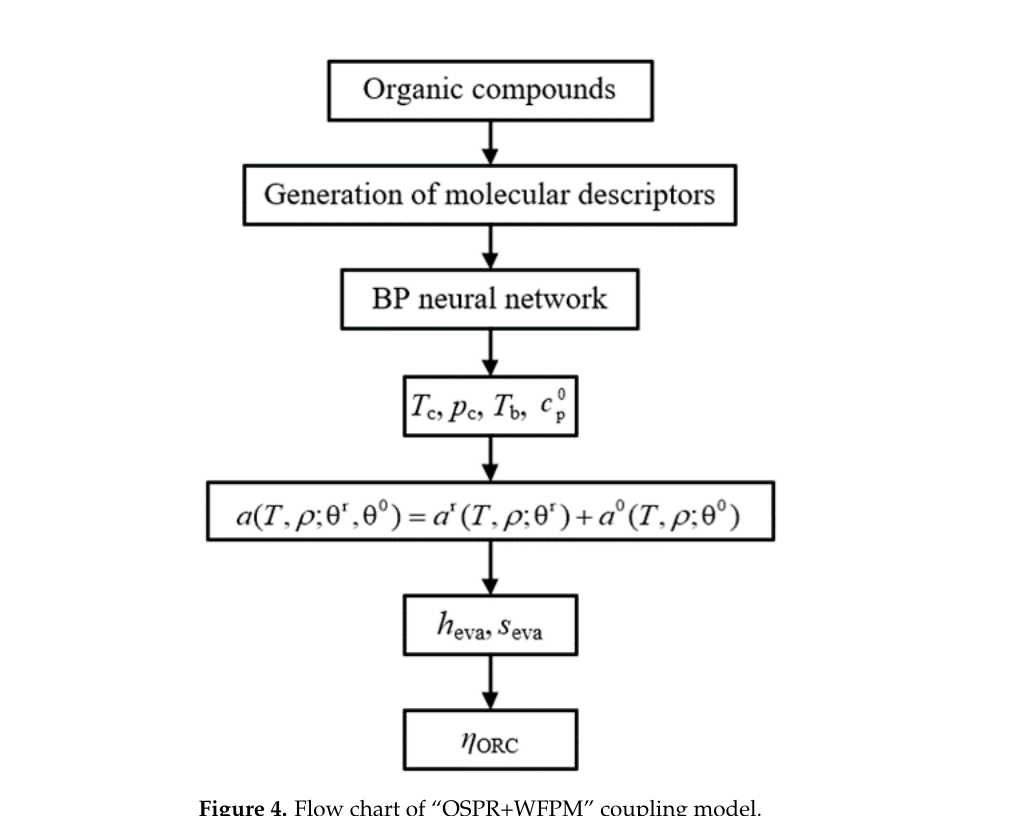
Table 4. RE of four working fluid